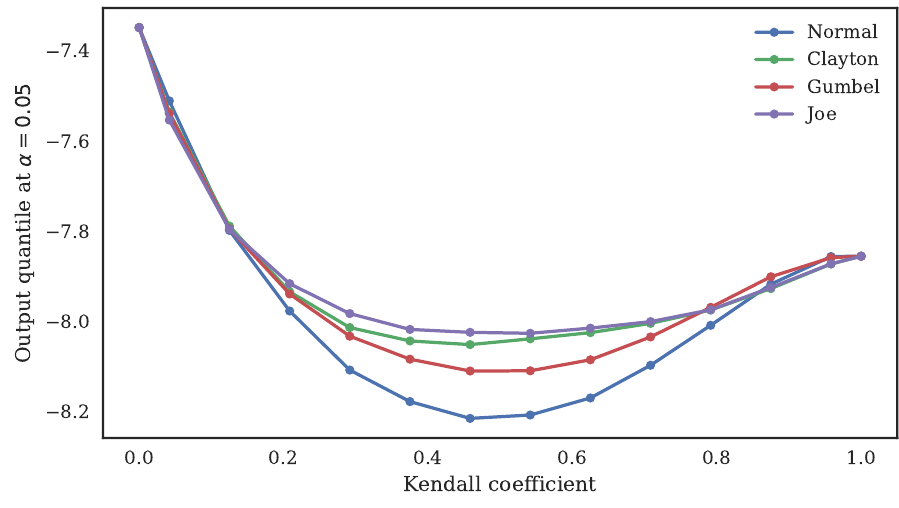
Figure 13: Variation of the output quantile with the Kendall coefficient τ for α = 5% and different copula families (Gaussian, Clayton, Gumbel and